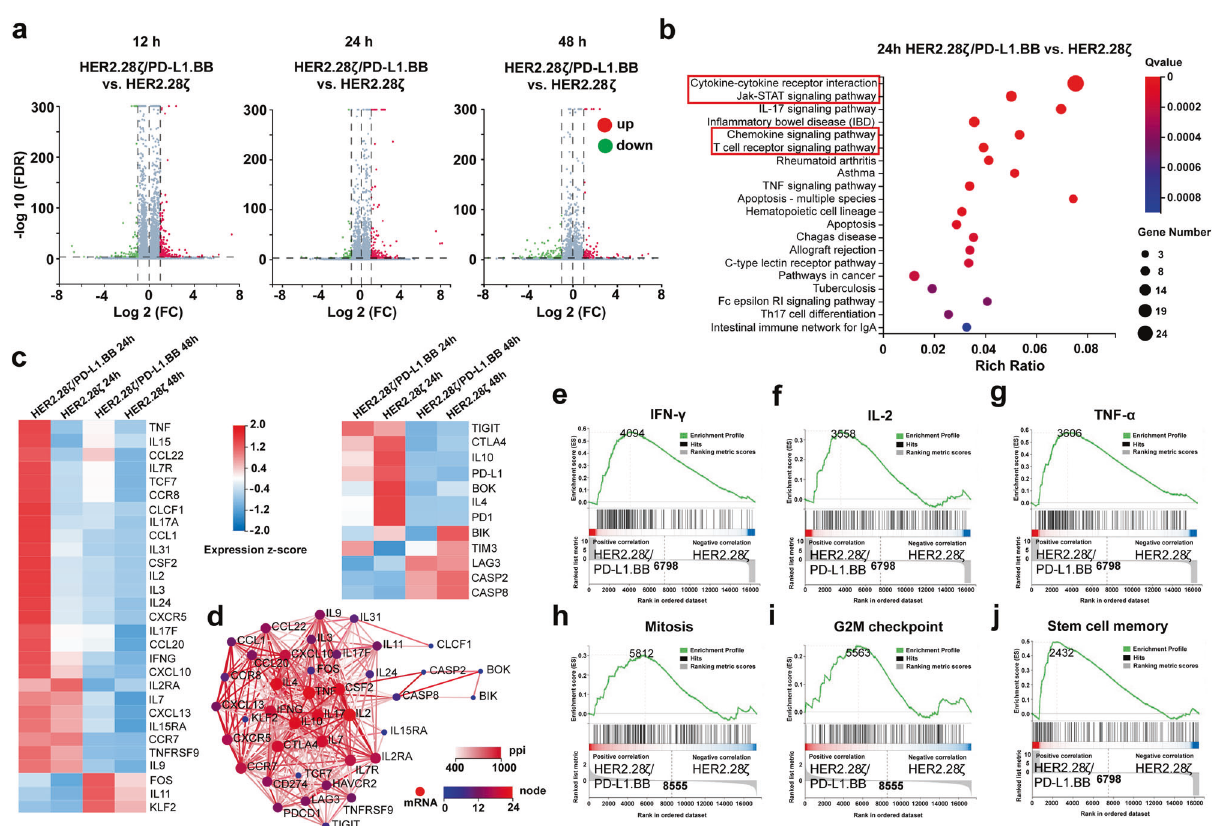
Fig. 6 PD-L1.BB CSR engagement upregulates T-cell activation, cytotoxicity, and proliferation related gene expressions in HER2.28 ζ /PD-L1.BB CAR-T cells. a RNA-seq analysis of HER2.28 ζ /PD-L1.BB and HER2.28 ζ CAR-T cells at 12 h, 24 h and 48 h after stimulation with irradiated SKOV3 PD-L1 cells, and the differentially expressed genes (DEGs) were shown in volcano plot (FC ≥ 2, Q ≤ 0.05). FDR, false discovery rate; FC, fold change. b Signi fi cant enriched KEGG pathway terms of DEGs between HER2.28 ζ /PD-L1.BB and HER2.28 ζ CAR-T cells at 24 h post-stimulation (FC ≥ 2, Q ≤ 0.001). c Heatmap of selected DEGs with different expression related to cytokine-cytokine receptor interaction, chemokine and T cell receptor (TCR) signaling pathways. d Analysis of protein-protein interaction (PPI) networks of DEGs between HER2.28 ζ /PD-L1.BB and HER2.28 ζ CAR-T cells 24 h after stimulation. e – j Gene-set enrichment analysis (GSEA) of IFN- γ e , IL-2 f , TNF- α g signaling pathways, as well as mitosis genes h , G2M checkpoint genes i and stem cell memory pathway j was performed on all gene sets at 24 h post-stimulation. Data shown are representative of 2